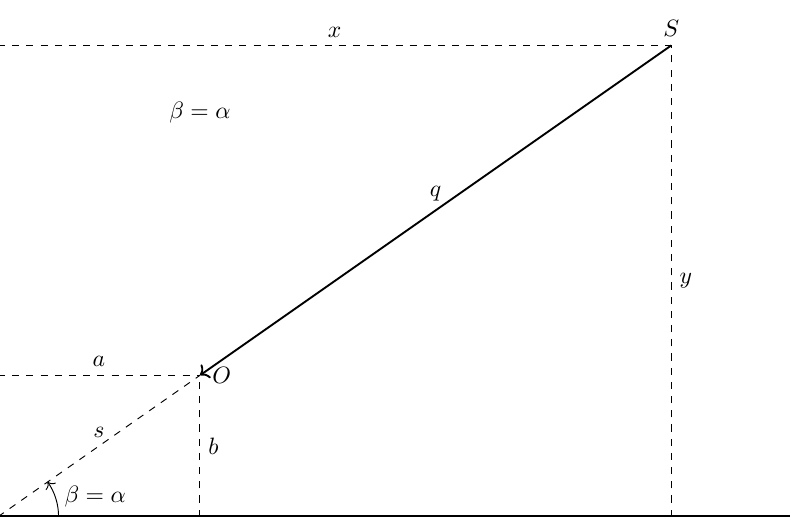
Figure A2: The intermediate case between the Figures 2 and A1 is that of the observer and source with the same elevation angle, that is, α = β and “double reflection” at the